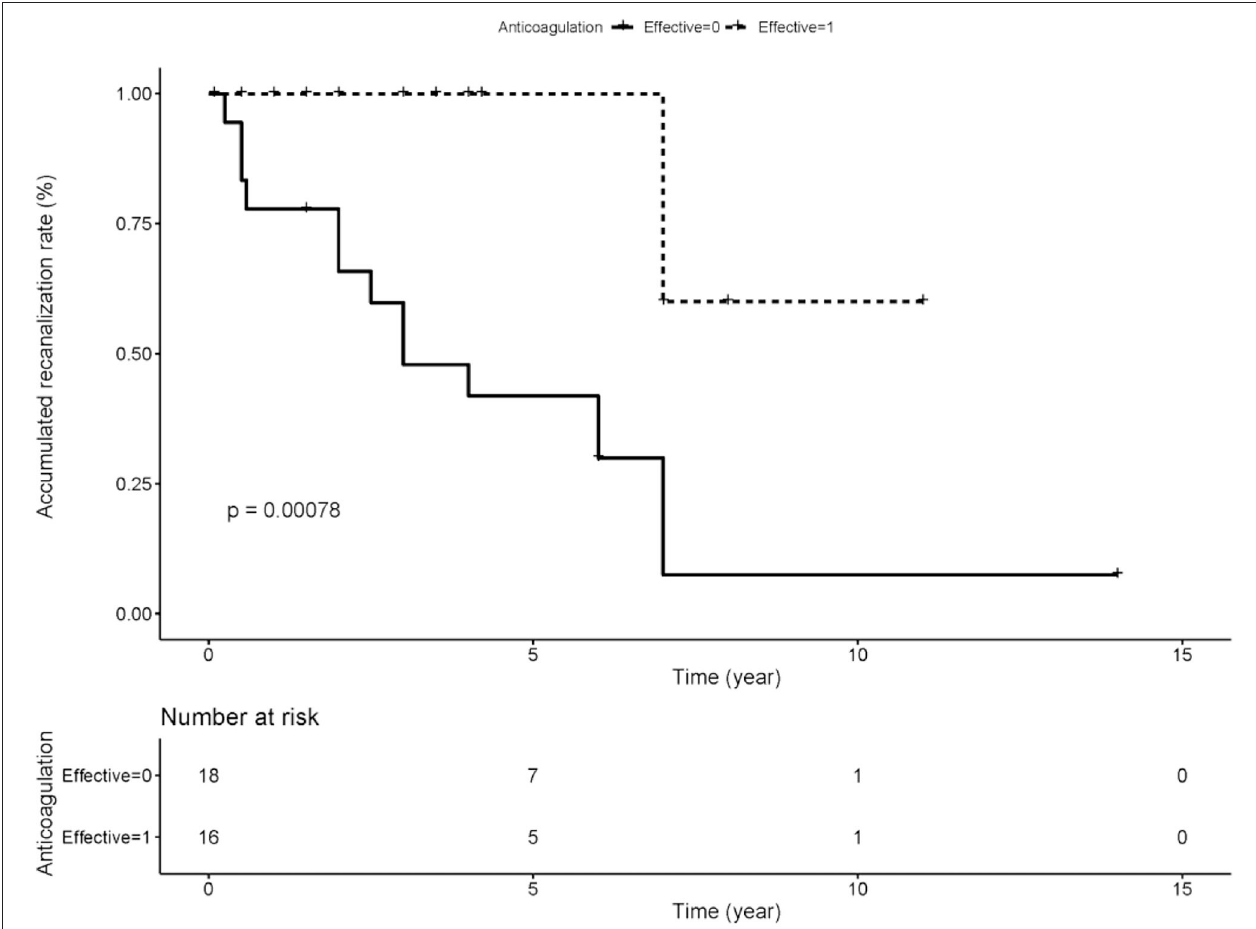
FIGURE 1 | Difference of accumulated re-canalization rate between groups receiving effective anticoagulation ( n = 16) and not ( n = 18). Effective anticoagulation was defined as immediate and sufficient anticoagulant therapy for at least 6 months with a target international normalized ratio (INR) of 2.0–3.0 from the time of portal vein thrombosis (PVT)